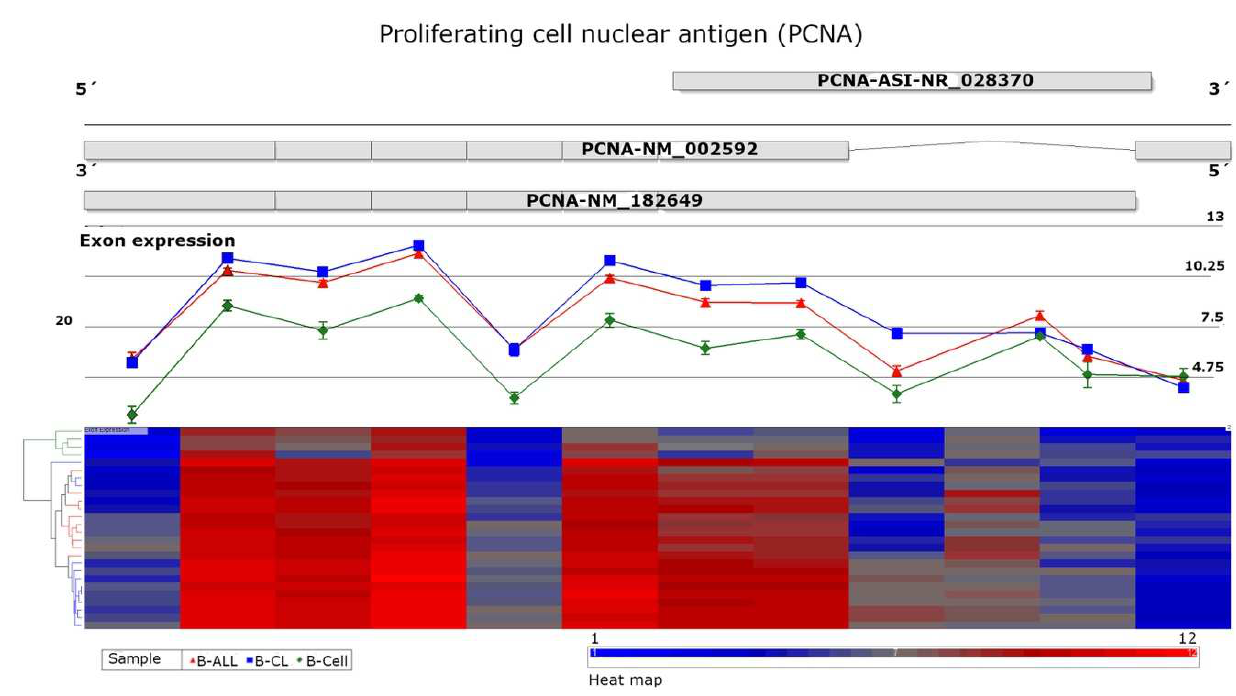
Figure 2. Exon expression profile of the proliferating cell nuclear antigen (PCNA) gene. The top of the figure shows possible splice variants of PCNA (PCNA-NM_002592; PCNA-NM_182649) in the antisense DNA chain and the sense noncoding DNA chain (PCNA-ASI-NR_028370). The middle of the figure depicts the mean of individual exon expression in red (B-cell acute lymphoblastic leukemia), blue (B-cell acute lymphoblastic leukemia cell lines), and green (healthy B cells). At the bottom is a heatmap of each exon level expression; the red color indicates high expression, and blue color indicates low expression. Significant differences in exon level expression were observed using ASANOVA with FRD value = 6.49 − 18